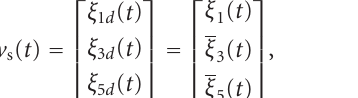
Figure 15: Nominal torques at the ankle, knee, and hip joint obtained via the inverse plant of the controller